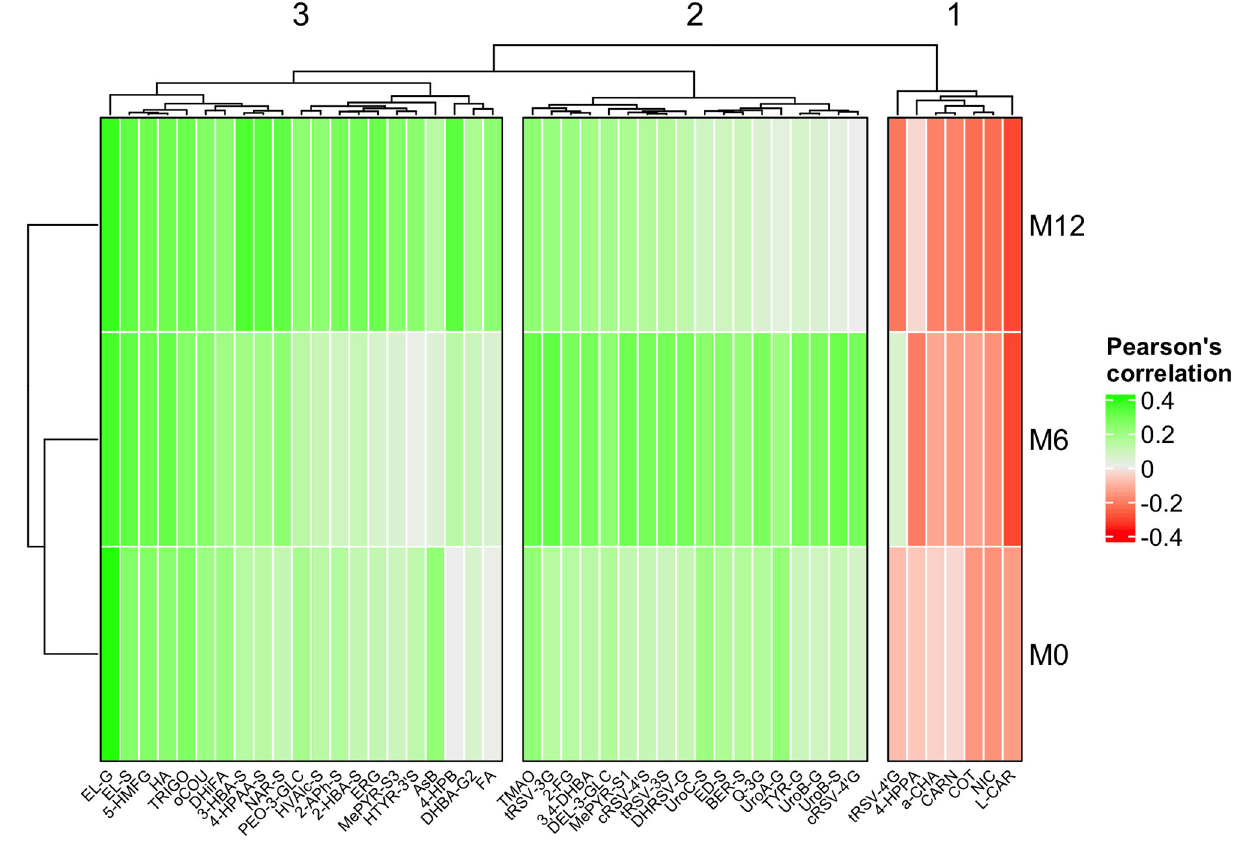
Frontiers in Nutrition |